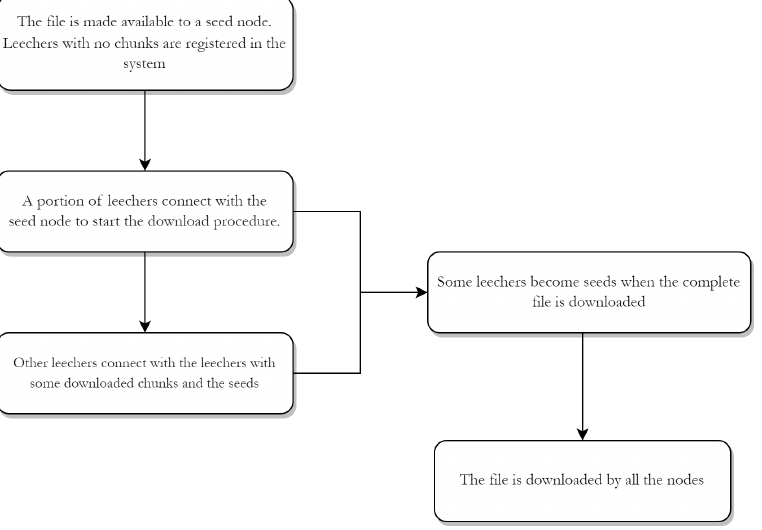
Figure 1. Flow chart for operation of the P2P